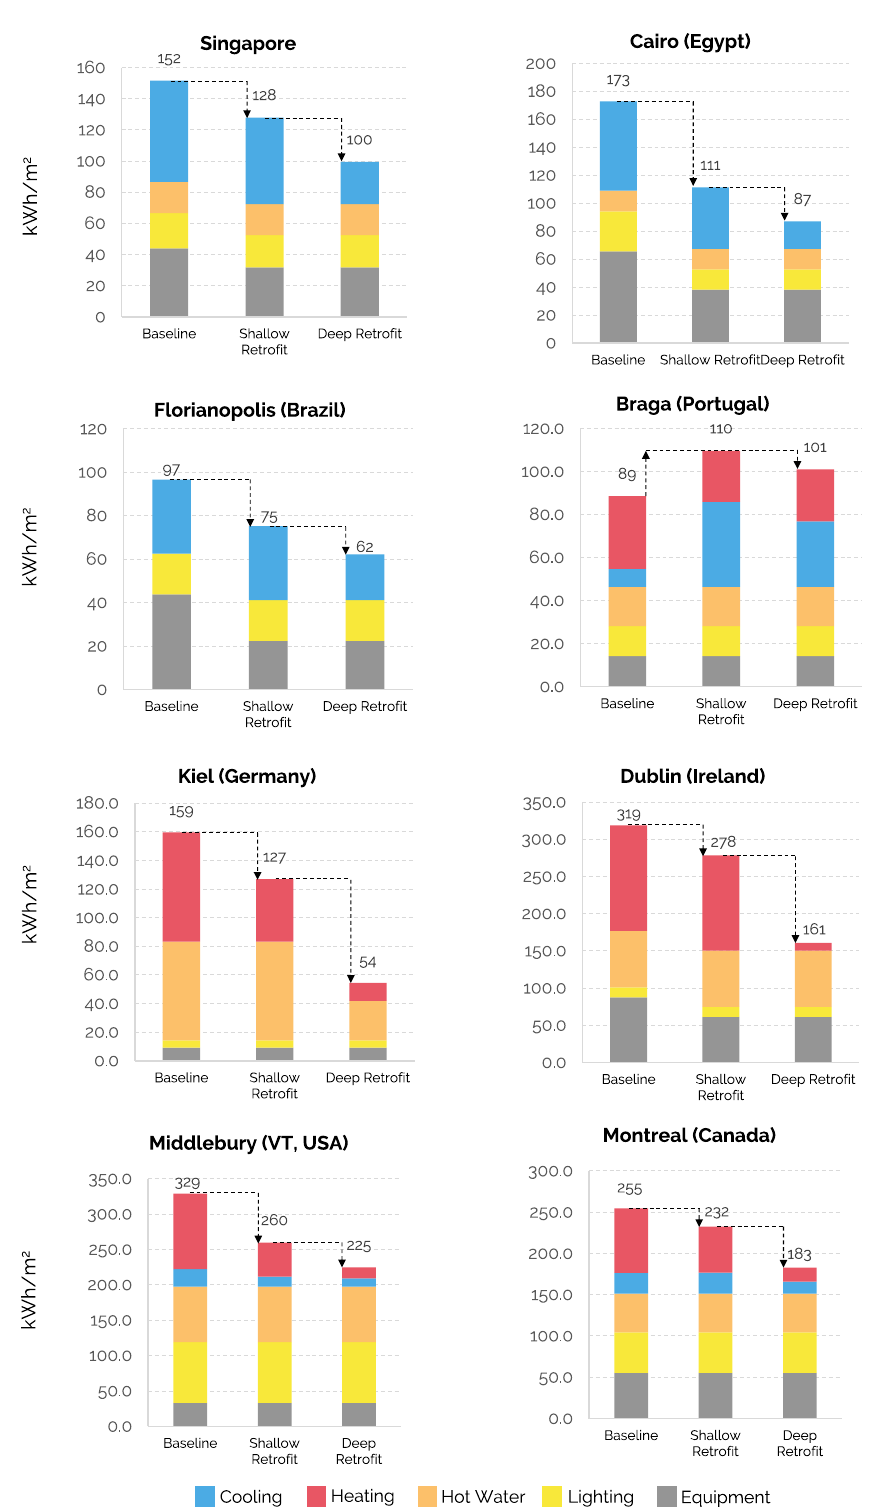
Fig. 2 | Energy Use Intensities (EUI) for the baseline and retro fi t scenarios for eightcities. Abaselineandtwoadditionalscenariosarede fi nedforeachcity,with the colors representing energy use intensities for various end uses. Shallow ret- ro fi ts naturally lead to smaller reductions in EUI, while deeper retro fi ts require